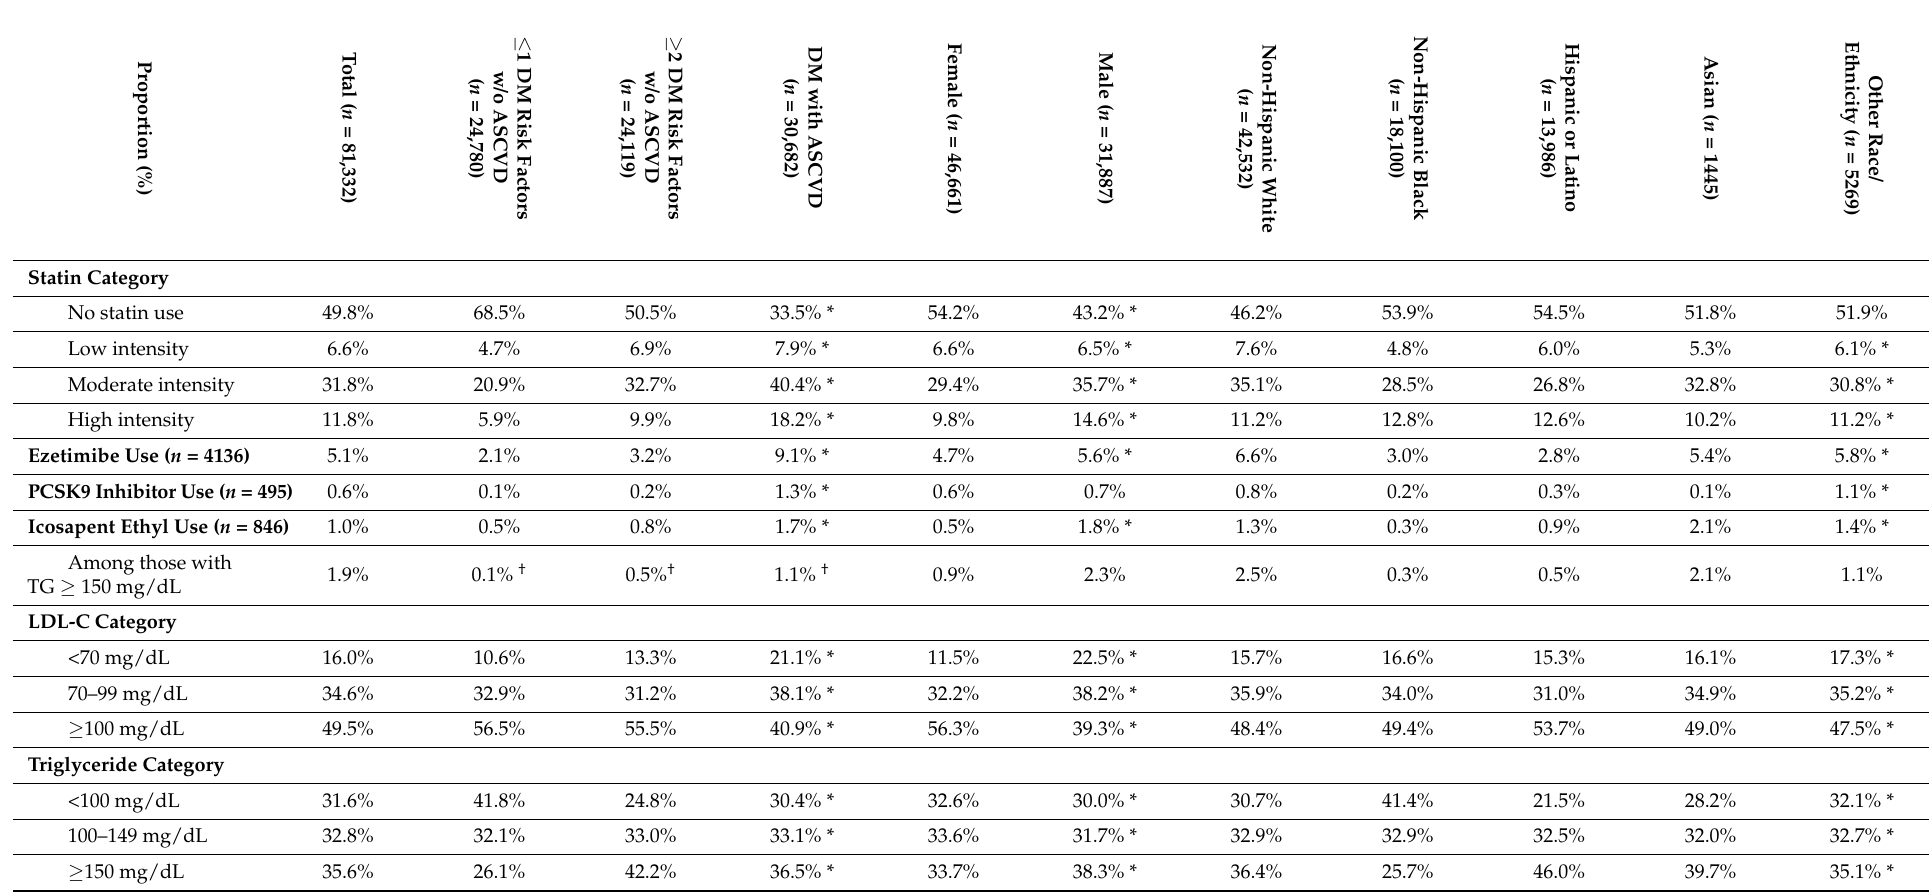
Table 2. Lipid treatment and control in US adults with DM according to risk group, sex and